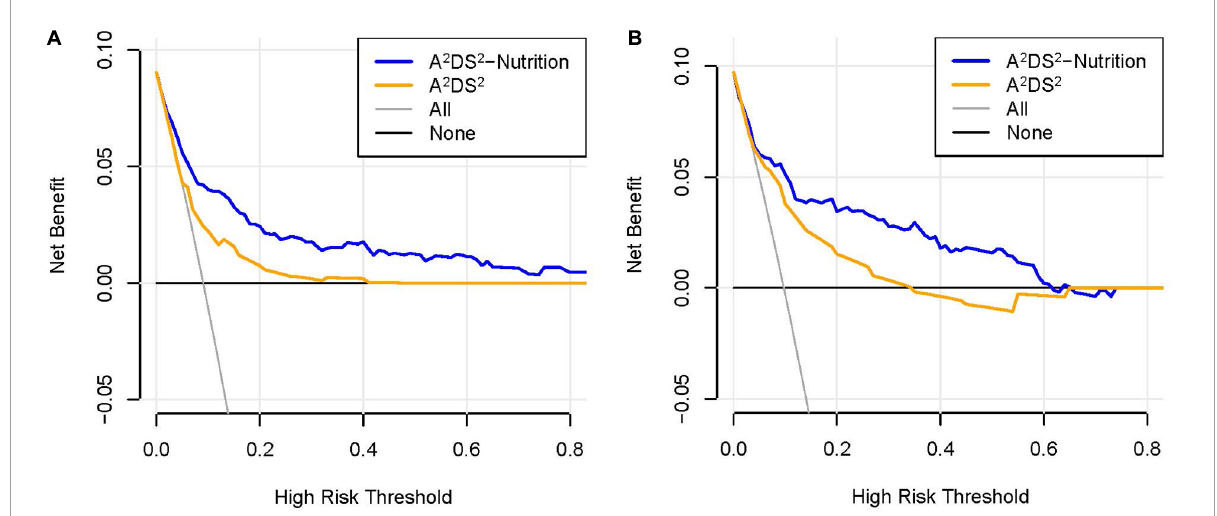
FIGURE6 Comparison of the decision curves between the A 2 DS 2 -Nutrition and A 2 DS 2 score. (A) The decision curve in the training group; (B) the decision curve in the validation group.